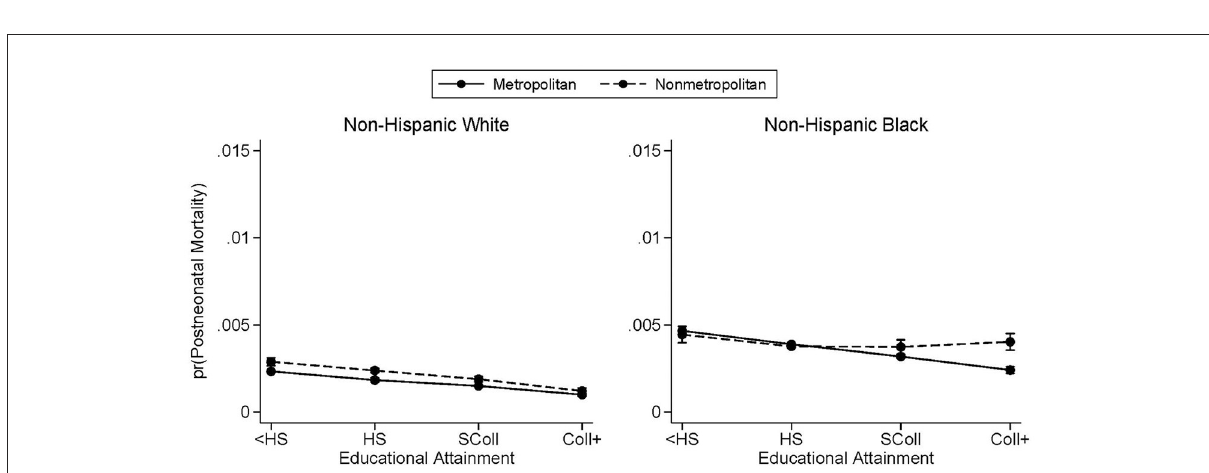
FIGURE4 Predicted probabilities of postneonatal mortality by metropolitan residence and race. Postneonatal mortality is infant death occurring between days 28 and 364. Predicted probabilities are from logistic regressions controlling for mother’s age, mother’s marital status, first trimester prenatal care, child’s sex, birth order, birth year, U.S. region of birth, and mother’s county of residence’s metropolitan status. See Supplementary Table 3 for full regression results. Births occurred between the years 2011 and 2015. Educational attainment is observed only from the revised birth certificates which had not yet been adopted by every